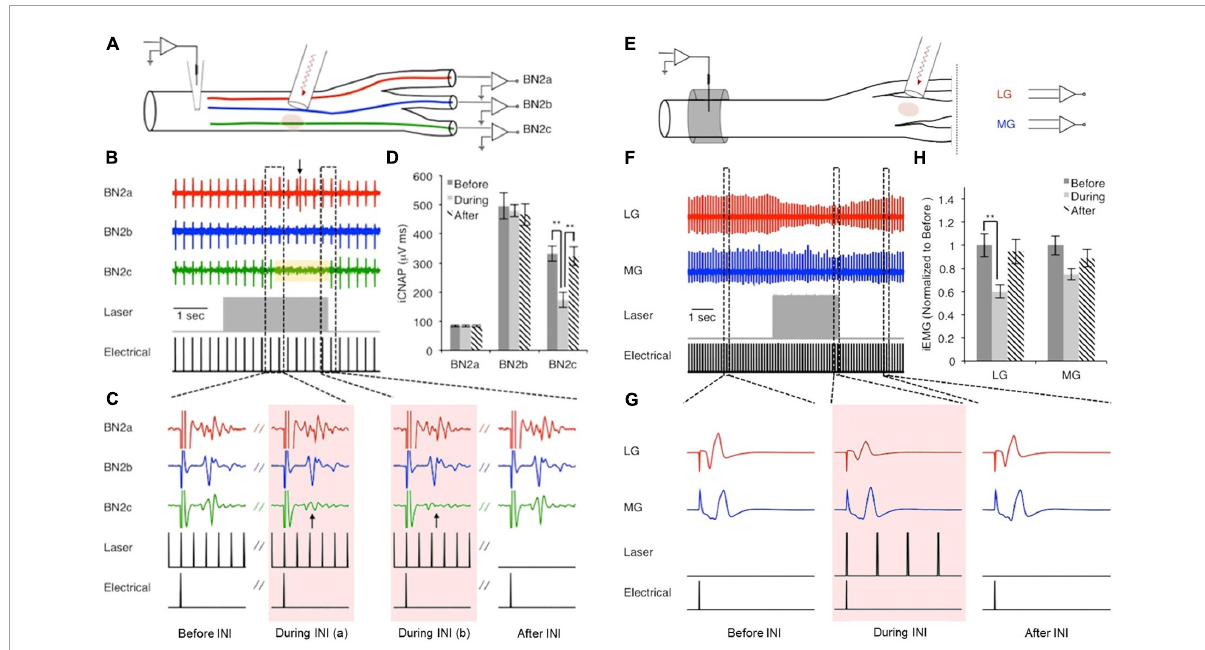
FIGURE2 Nerve conduction block in buccal nerve 2 (BN2) of Aplysia (A–D) and in rat sciatic nerve (E–H) . Panels (A–D) : A train of low radiant exposure (0.50 ± 0.02 J/cm 2 ), high frequency (200 Hz) infrared pulses ( λ = 1,450 nm, pulse width = 0.2 ms) produced a rise in local tissue temperature and blocked responses projecting to BN2c. Panel (A) : Experimental setup; panel (B) : Overall view of the recorded responses; panel (C) : Representative signals showing the response before, during (arrow indicates block of CAP), and after the presence of infrared neural inhibition effect; panel (D) : Calculated area under the curve showed the spatial selective inhibitory effect. Panels (E–H) : Similarly, applying infrared pulses (same temporal parameters, 75.7 ± 5.3 mJ/cm 2 ) to the tibial branch of the rat sciatic nerve, approximately 1 cm distal to the site of electrical stimulation, reduced evoked EMG amplitude of the lateral gastrocnemius (LG) but not the medial gastrocnemius (MG). Panel (E) : Experimental setup; panel (F) : Overall view of the recorded responses; panel (G) : Representative signals showing the response before, during, and after the infrared light application; panel (H) : Calculated area under the curve showed the spatial selective inhibitory effect. [Reproduced with permission from Duke et al. (2013). The original work is published under a Creative Commons Attribution-Non-commercial-NoDerivs 3.0